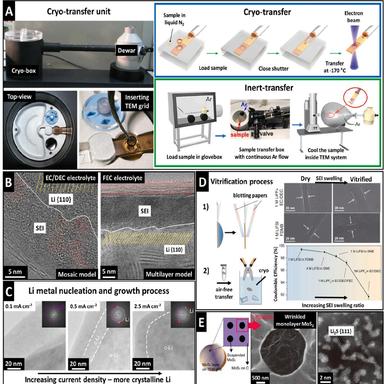
(A) Photographs of a double-tilt liquid nitrogen cryo-holder in a cryo-transfer workstation and schematic illustrations of inserting a TEM grid into the holder for a cryo-transfer and inert-transfer process; adapted from Ref. with permission from Elsevier, from Ref. with permission from AAAS, with permission from Ref., Copyright 2017 American Chemical Society, by permission from Springer Nature: Copyright 2014. (B) TEM images of Li metal and the SEI grown